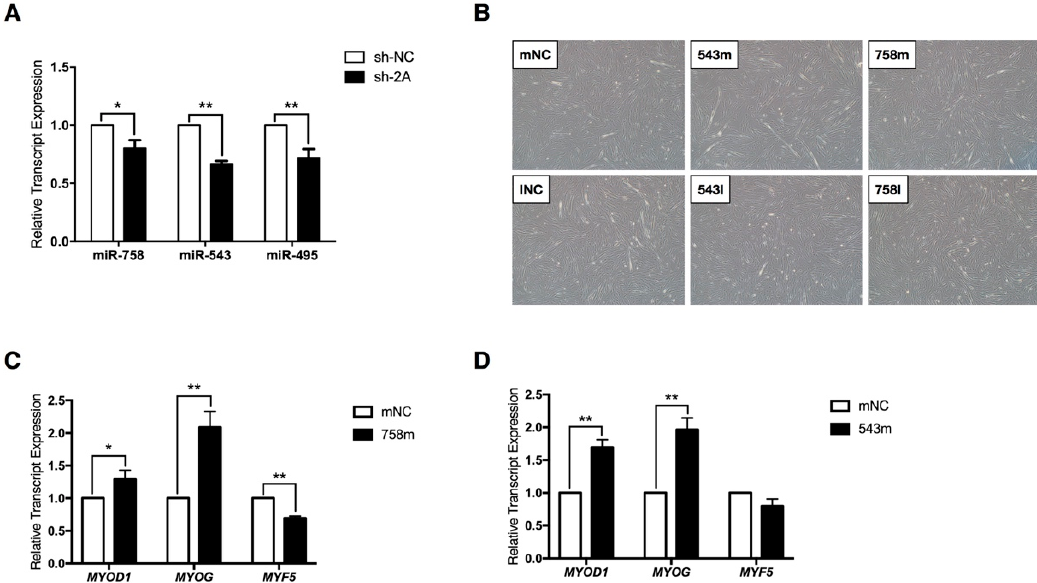
Figure 4. MEF2A regulates MEG3-DIO3 miRNAs during myoblast differentiation. ( A ) RT-PCR analysis of miR-758, miR-543, and miR-495 in MEF2A-depleted myocytes; ( B ) Overexpression and inhibition effects of miR-758 and miR-543 on myoblast differentiation (magnification: 40×); ( C ) RT-PCR analysis of MYOD1 , MYOG , and MYF5 upon miR-758 mimics transfection during myoblast differentiation; ( D ) RT-PCR analysis of MYOD1 , MYOG , and MYF5 upon miR-543 mimics transfection during myoblast differentiation. Error bars represent SEM. “*” represents p < 0.05. “**” represents p < 0.01.